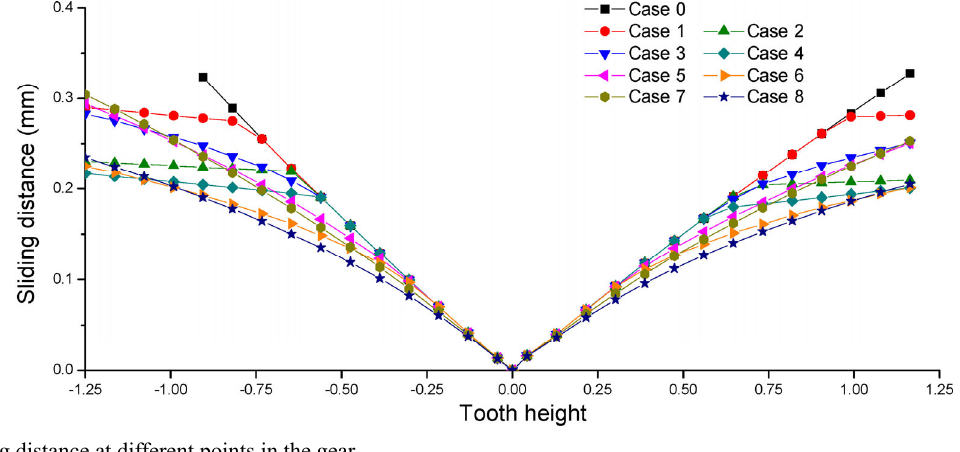
Fig. 9 Sliding distance at different points in the gear.